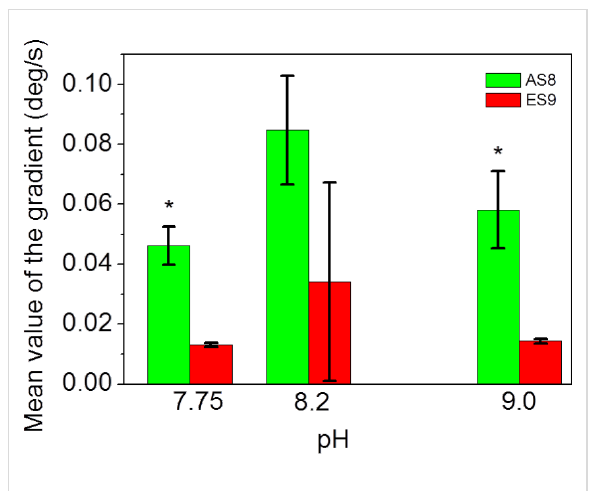
Figure 8: Evaluation of the slope observed in peptide experiments as shown in Figure 6C. For experimental values, see Supporting Informa- tion File